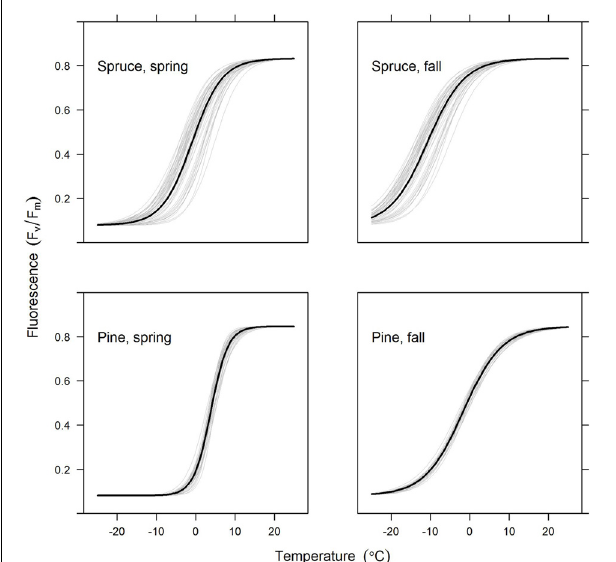
FIGURE 4 | Predicted chlorophyll fluorescence ( F v / F m ) as a function of temperature for the spruce and pine needles (upper and lower rows, respectively) and for the old and new needles (left and right columns, respectively). The thick lines show the average model for all trees in the group, with thin lines indicating individual trees. Figures are based on the best-fitting model using a 7-day sliding average of daily mean temperature.